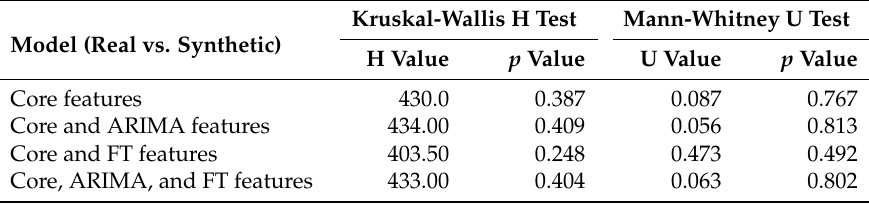
Table 4. Kruskal-Wallis H Test and Mann-Whitney U test (Building Genome data